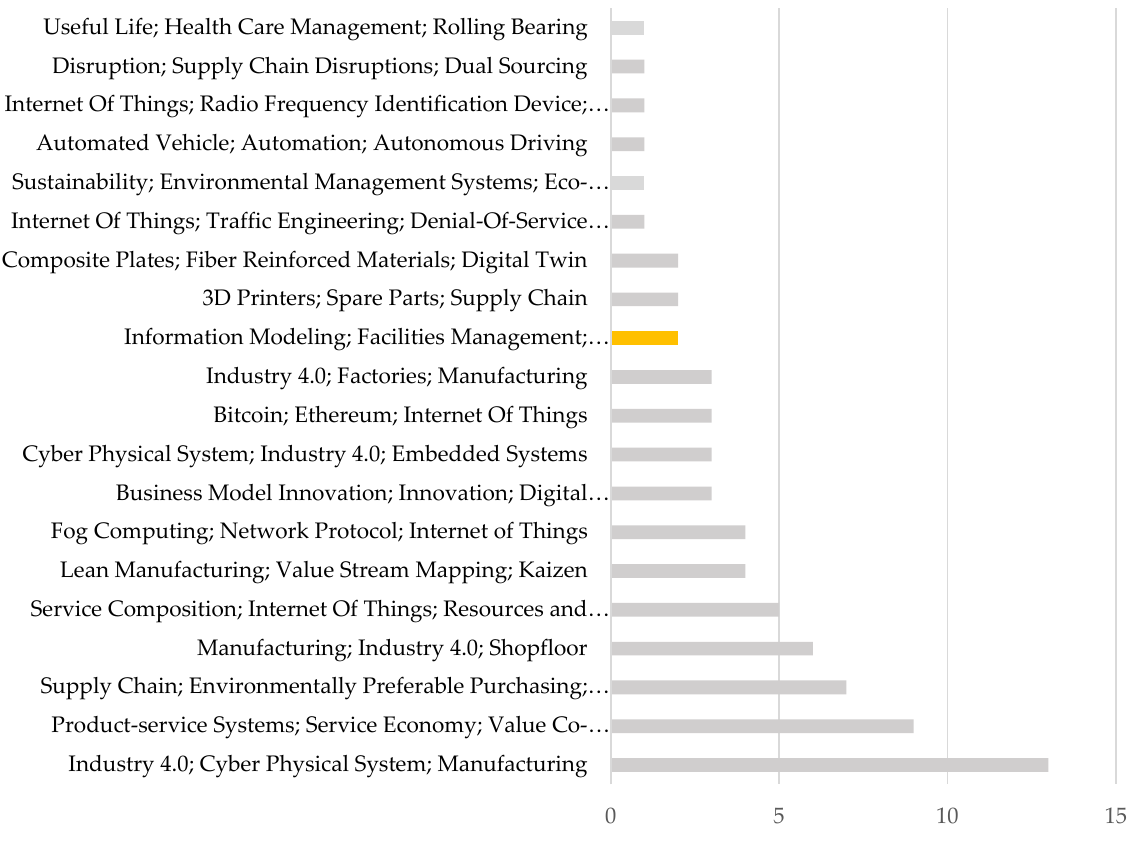
Figure 7. Top 20 Industry 4.0 topics by scholarly output.